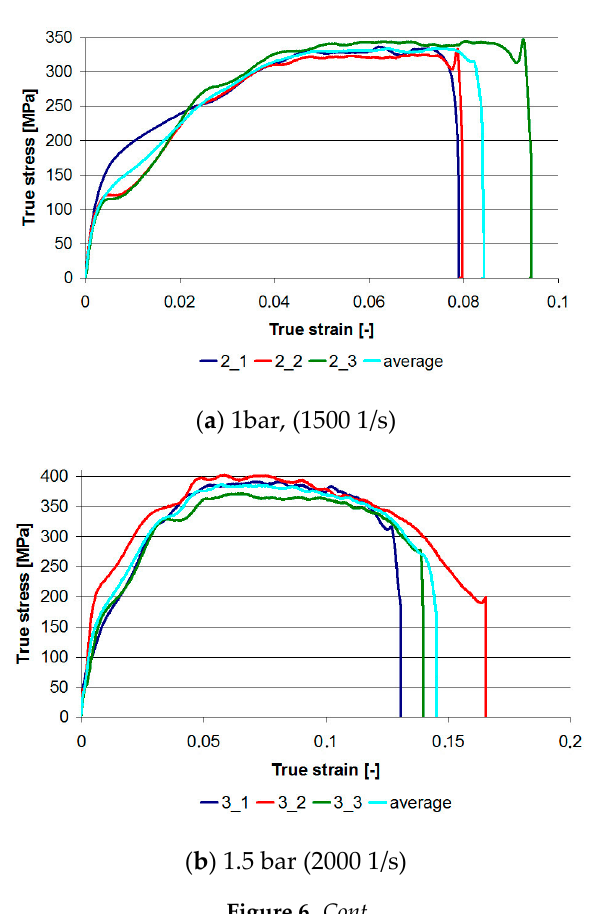
( c ) 2 bar (2500 1/s) Figure 6. True stress–true strain graphs for three loads in dynamic compression tests at ambient temperature. ( a ) 21 °C—samples 2_1 to 2_3 ( b ) 21 °C—samples 3_1 to 3_3 ( c ) 21 °C—samples 4_1 to 4_3. In the tests, the loads were selected in such a way as to obtain three different effects, visible both on the graphs and on the sample microscopic observations. Taking into account part of the graph after reaching the maximum stress, for a load of 1 bar we obtained a relatively long flat section; for a load of 1.5 bar, a slight curvature (stress drop); and for a load of 2 bar, the stress decreased linearly and rapidly. The effects described are reflected in the microscopic observations of samples after testing. For a 1 bar load (Figure 7), none of the samples were damaged. There are also no visible cracks or plastic deformations. Thus, the loads applied were safe.